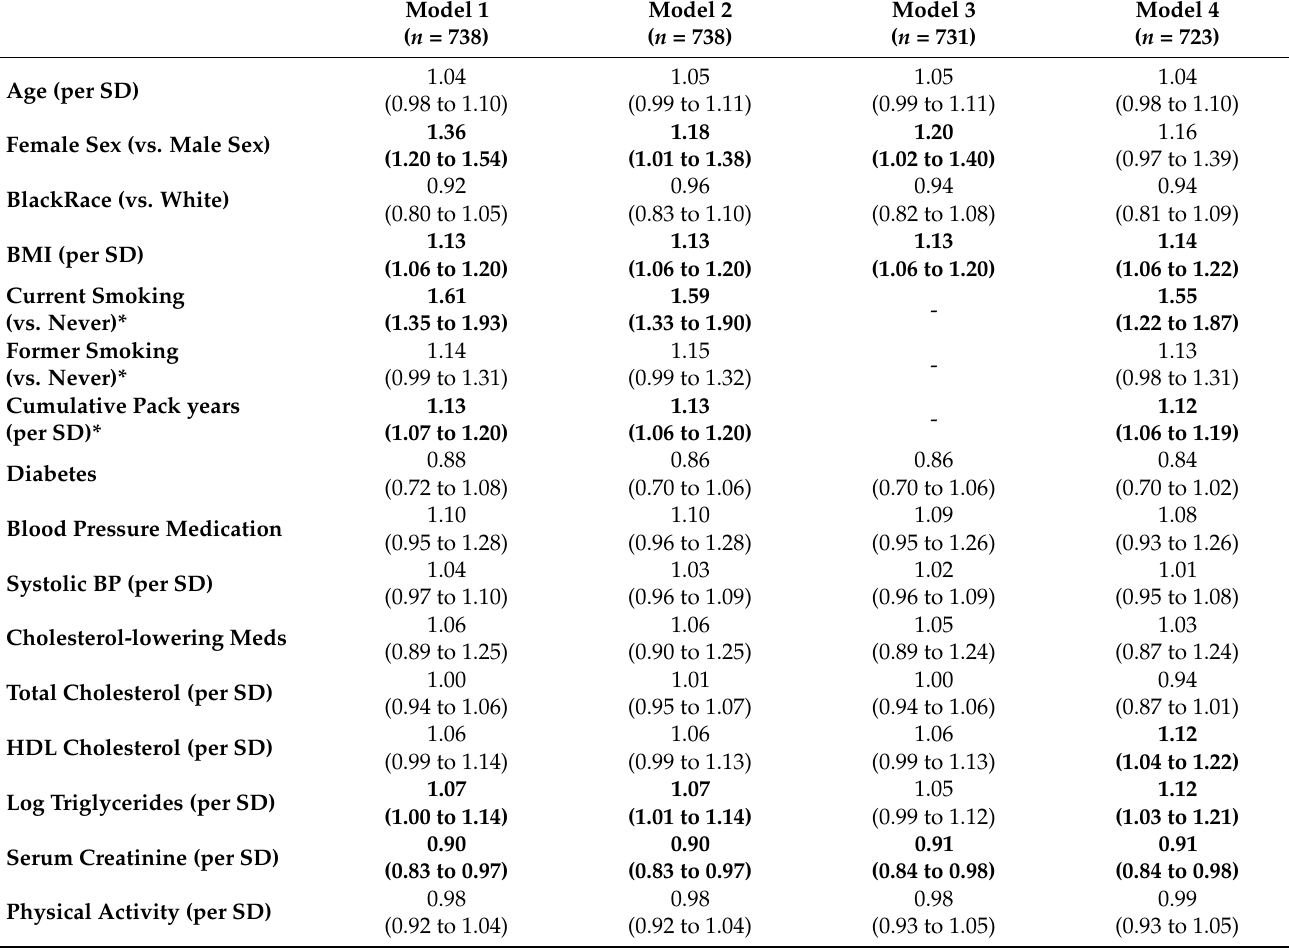
Table 3. Adjusted associations between IsoP m vs. cardiovascular risk factors. Model